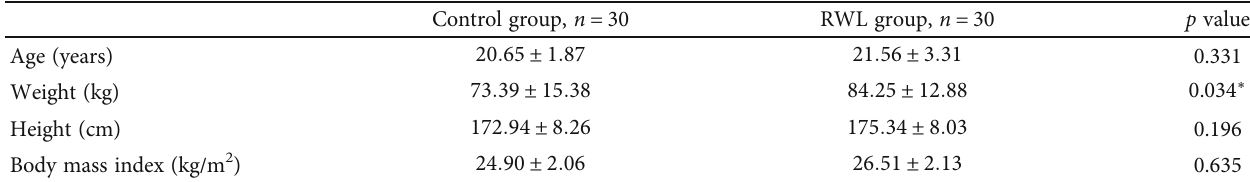
Table 1: Demographic data of the control and RWL group.